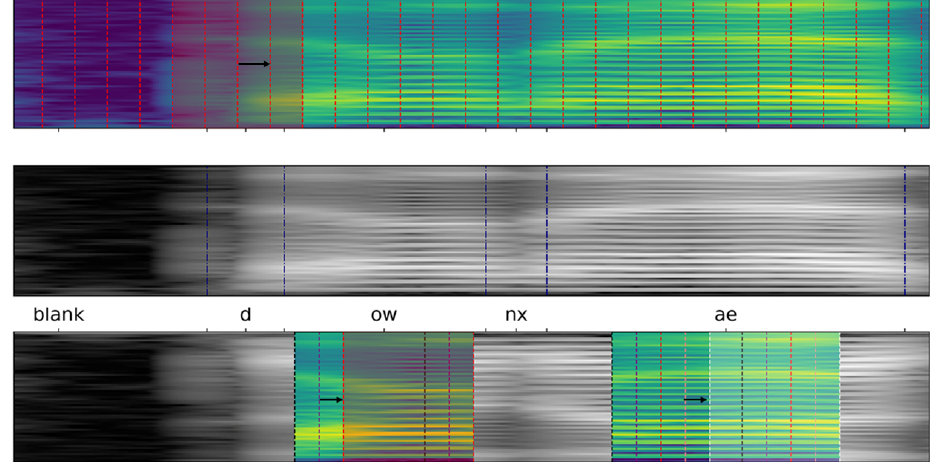
Figure 2. Mel-Spectrogram slicing scheme for building example sets for a conventional sliding window-based procedure ( top ) and for the proposed concept ( bottom ). In the latter case, windows are extracted only within a central region of an articulation period. Original spectrogram, together with phoneme annotations, is shown for reference in the ( middle )